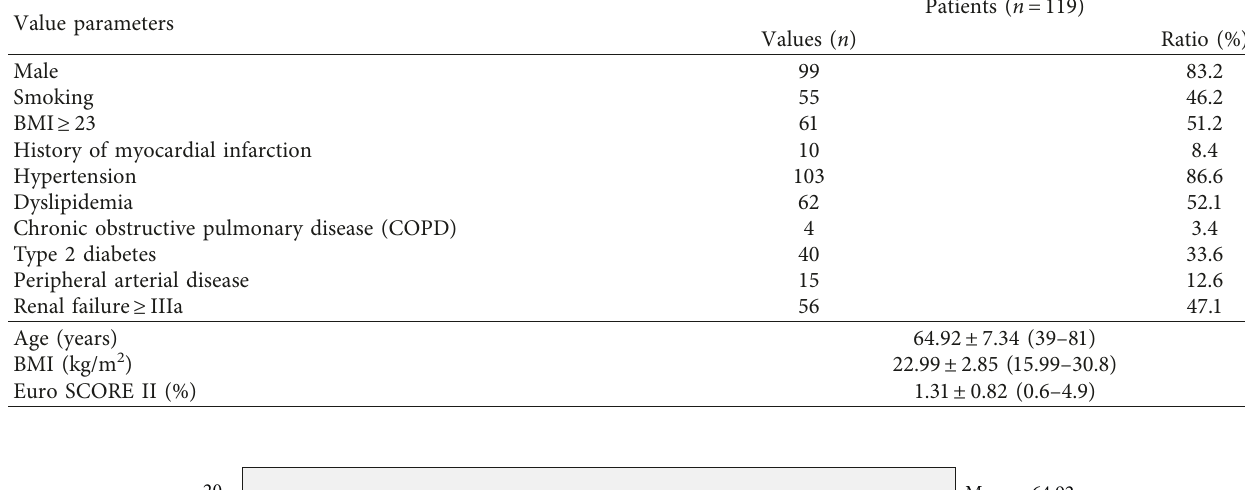
Table 1: General characteristics, risk factors, and